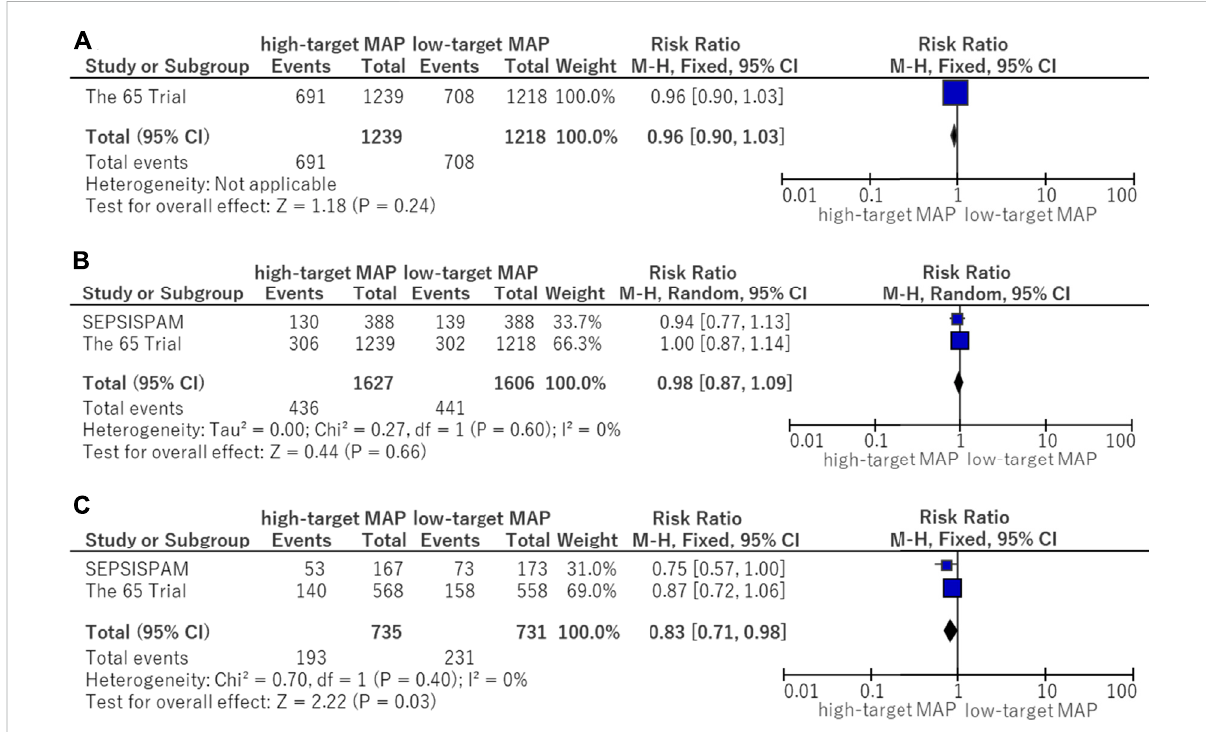
FIGURE 4 ForestplotofthecomparisonofahigherMAPversuslowerMAP:secondaryoutcomes. (A) Useofadvancedrespiratorysupport. (B) Useofrenal